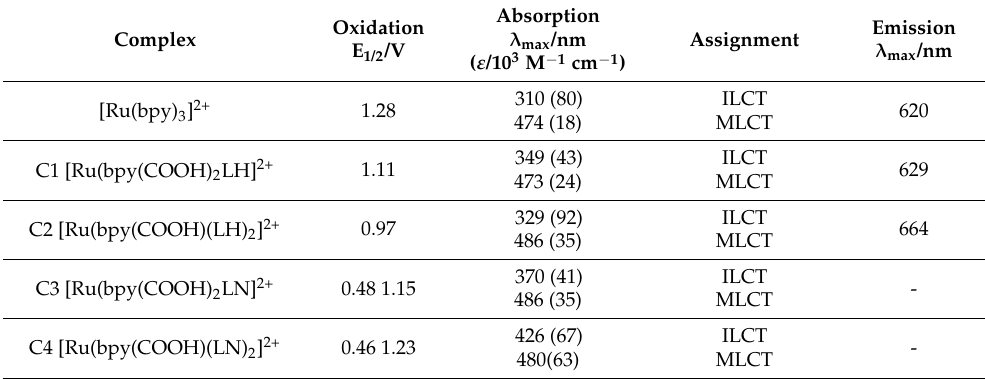
Table 1. Electrochemical and UV–Vis absorption data for C1–C4 complexes.